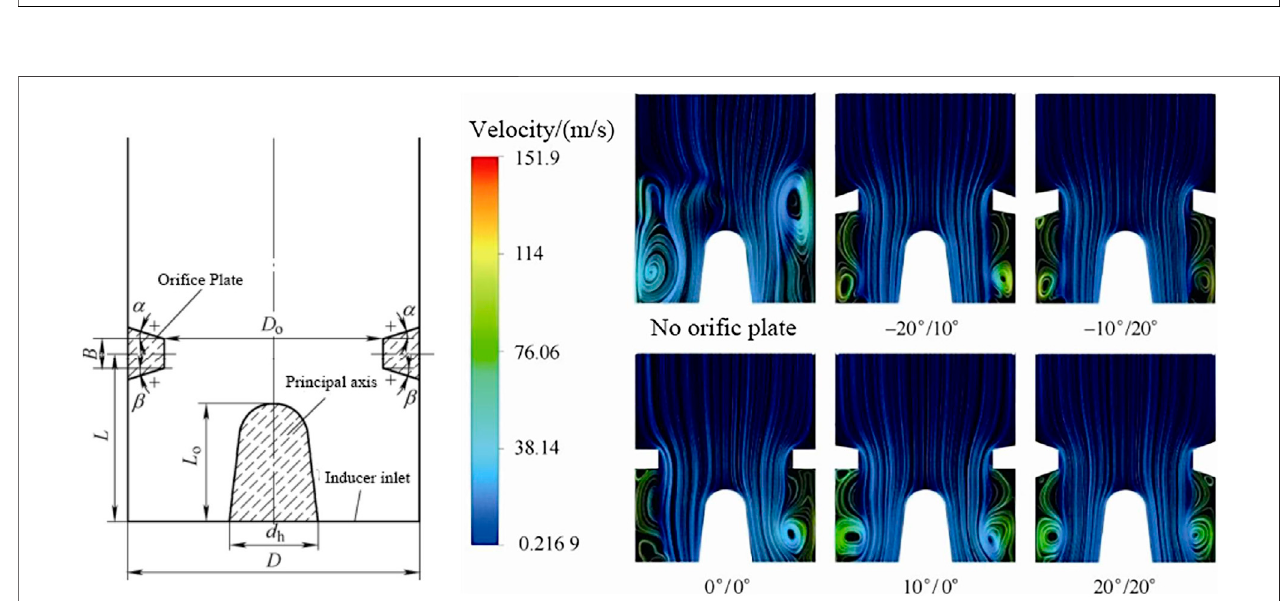
FIGURE 10 | Ori fi ce plate structure and sketch of the axial section (Song Wenwu, 2020).